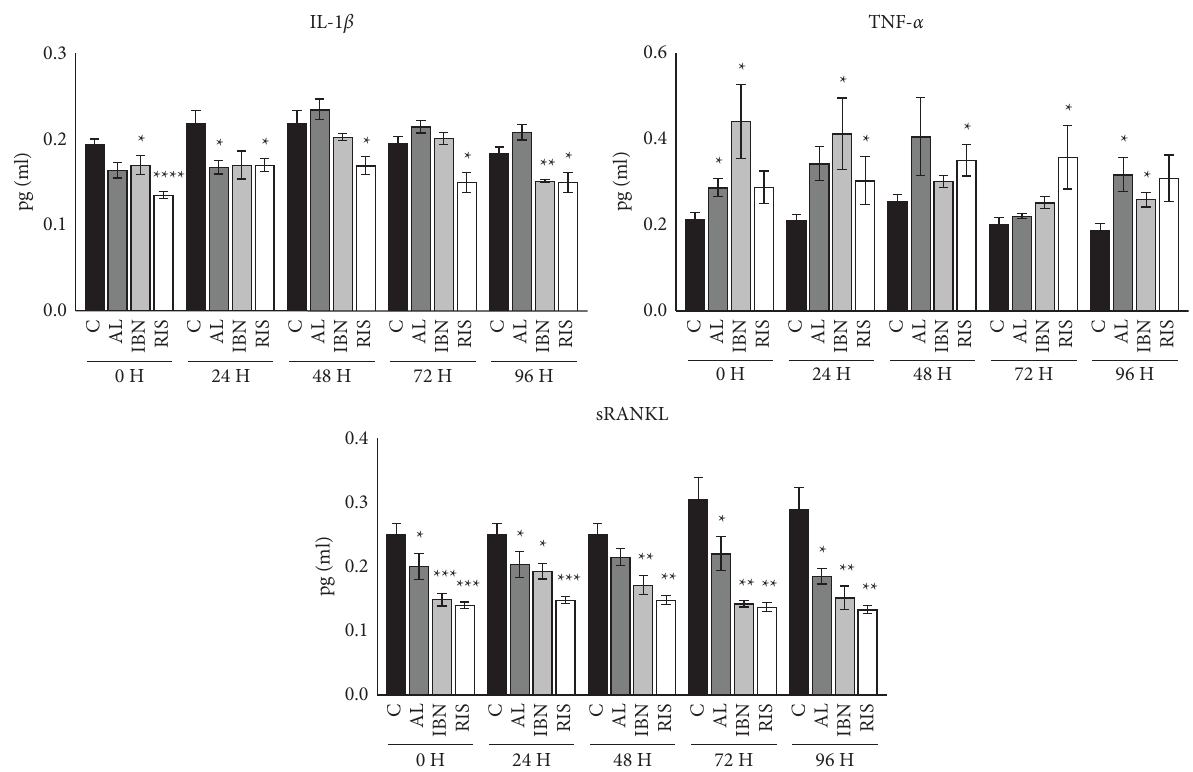
Figure 2: Osteoclastic cultures were stimulated with nitrogen-containing bisphosphonates at 10 − 5 M for 0h, 24h, 48h, 72h, or 96h, and the culture medium was analysed by ELISA for IL-1 β , TNF- α, and sRANKL. Black bars represent the control cell group; AL: alendronate, IBN: ibandronate, and RIS: risedronate. Te results are expressed as the mean ± SD of 5 cultures. Signifcant diferences between the experimental and control groups: ∗ P < 0 . 01, ∗∗ P < 0 . 001, ∗∗∗ P < 0 . 001, and ∗∗∗∗∗ P < 0 . 0001.